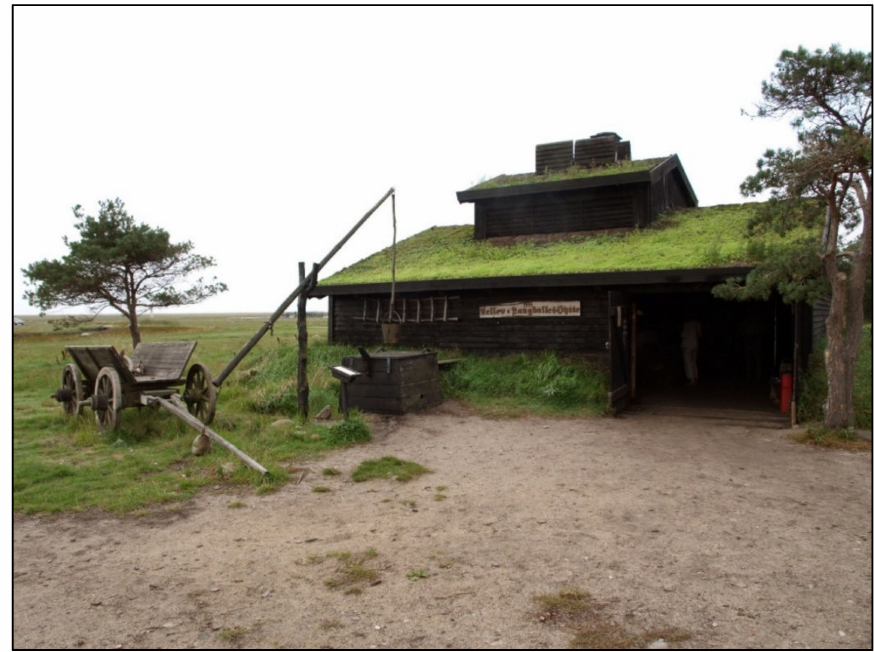
Figure 6. Restored salt-making hut in the saltworks of Læsø, according to the findings of the archaeological excavations conducted in 1990. Own